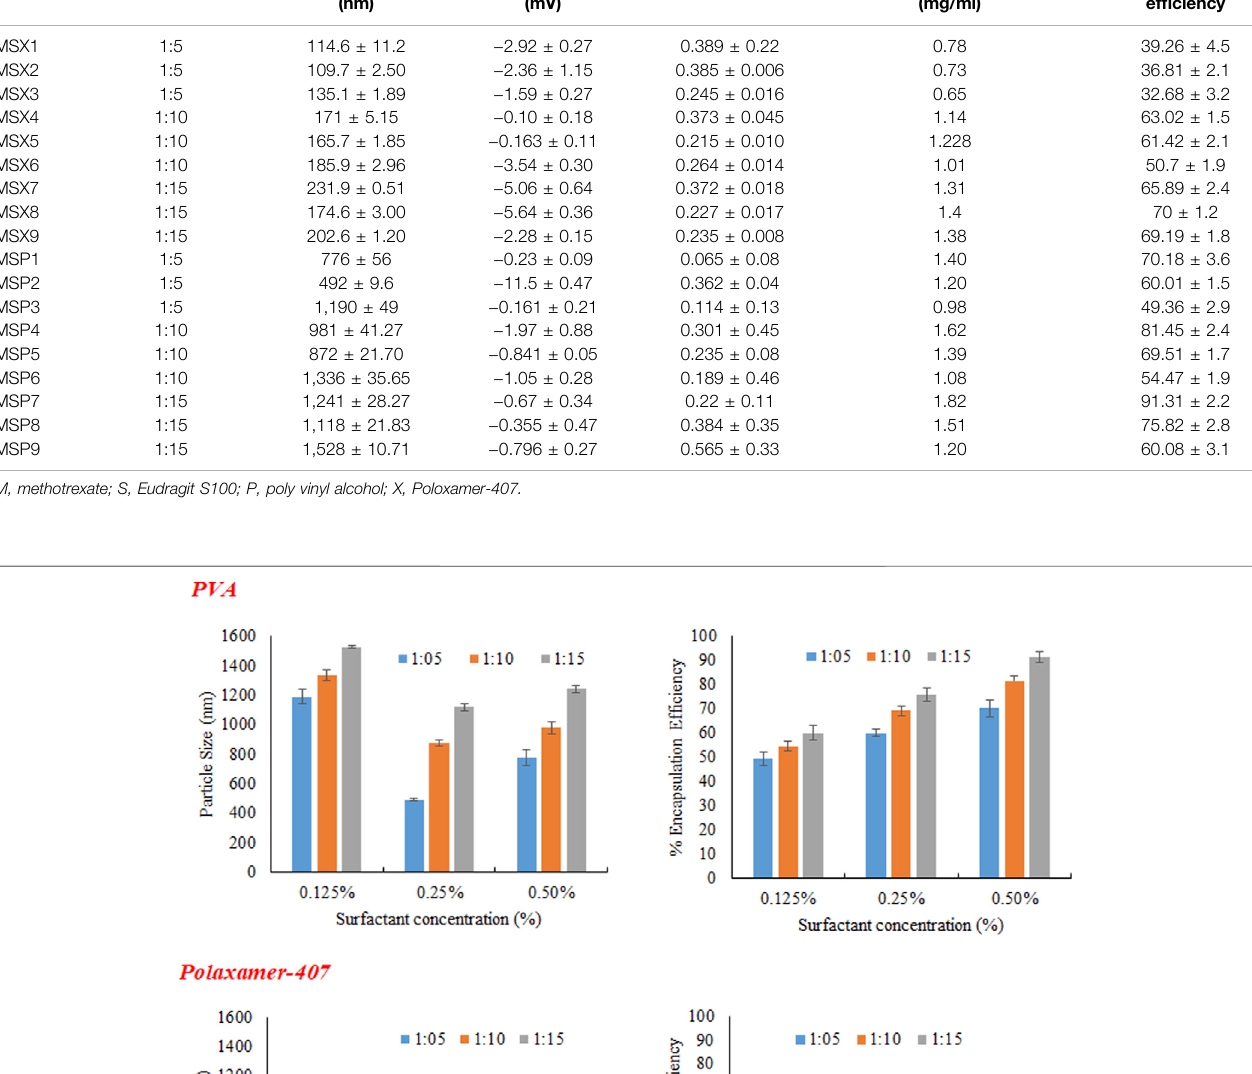
Frontiers in Pharmacology |